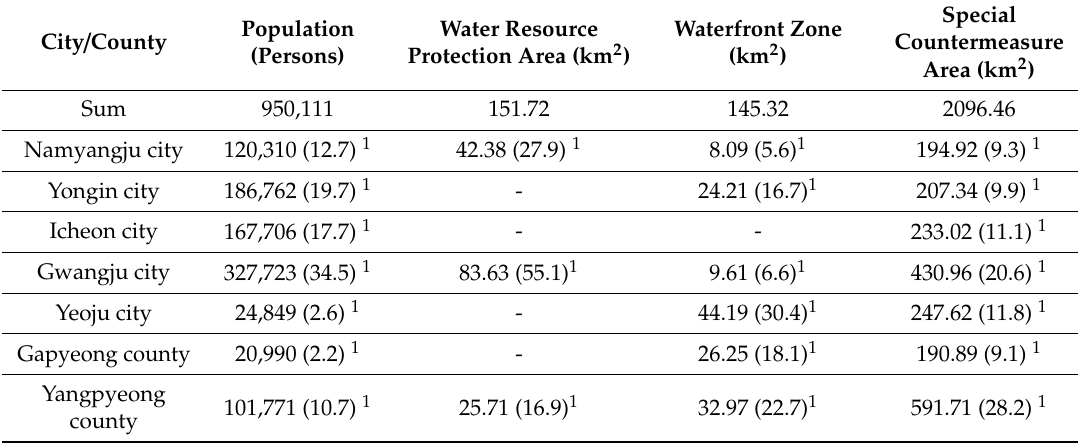
Table 1. The general status for regulation regions of the Paldang